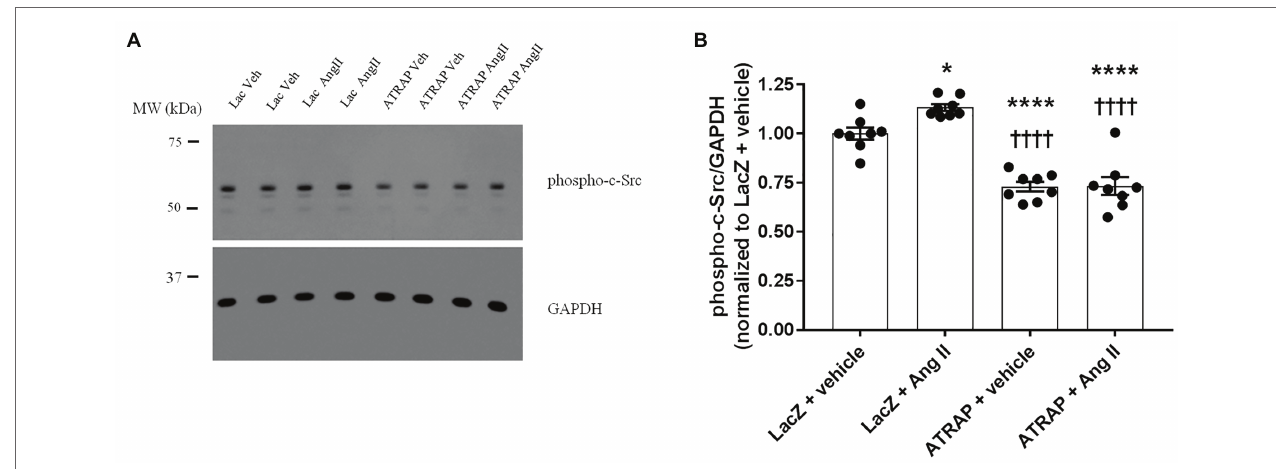
FIGURE 5 | The effect of Ang II on the levels of phospho-c-Src in radioimmunoprecipitation assay (RIPA)-soluble lysates from M-1 cells overexpressing LacZ and ATRAP protein. M-1 cells overexpressing LacZ-V5 and ATRAP-V5 were acutely treated with vehicle or 10 −10 M Ang II for 15 min and assessed for c-Src phosphorylation status. (A) Representative immunoblot of phospho-c-Src ( Supplementary Material ). (B) Graphical representation of the ratio of phosphorylated Src to GAPDH ( n = 8). * p < 0.05; **** p < 0.0001 vs. vehicle-treated LacZ-M-1 cells. †††† p < 0.0001 vs. Ang II-treated-LacZ-M-1 cells. All statistical analyses were performed using ANOVA, followed by Bonferroni post hoc